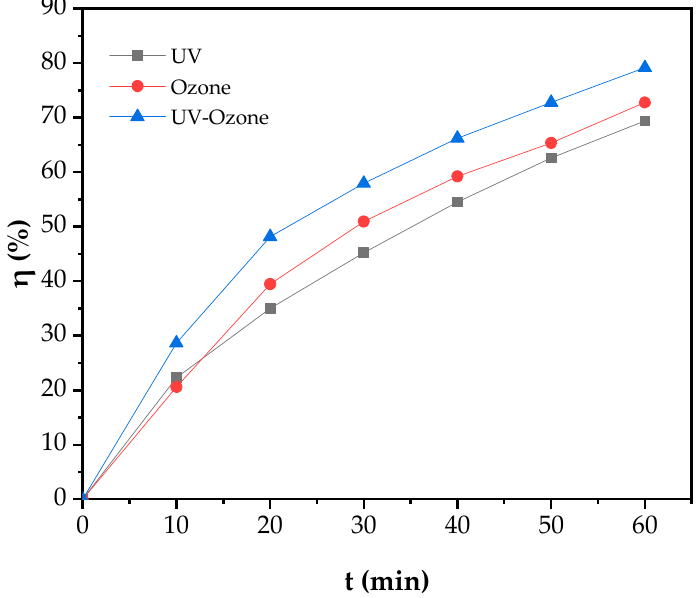
Figure 2. Comparison of UV, Ozone, and UV-Ozone combination processes.